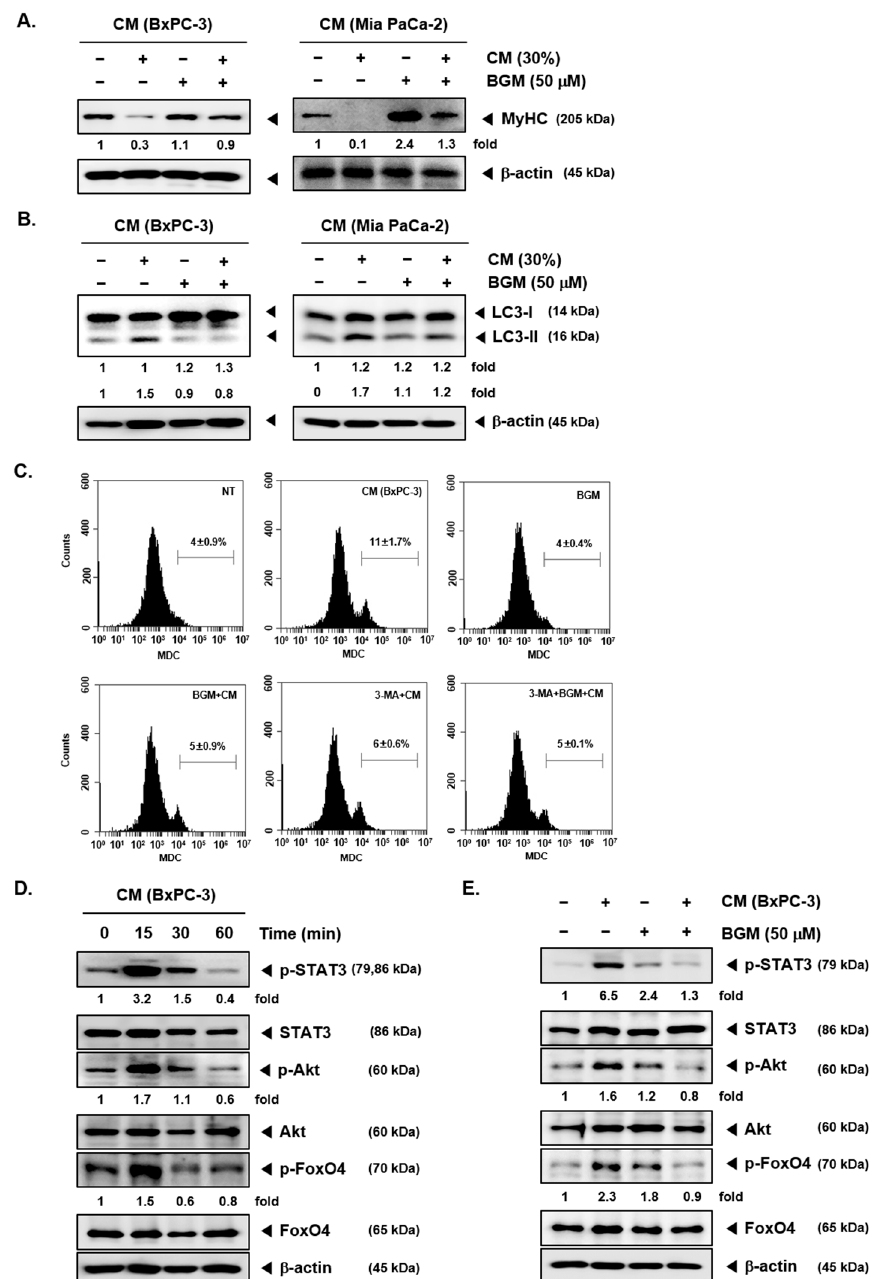
Figure 2. Effects of BGM on autophagy activation and various cancer markers suppression levels in C2C12 cells. C2C12 cells were treated by BGM (50 µM) with 30% of BxPc-3 and MIA PaCa-2 cells CM for 24 h. The lysates were analyzed by Western blot analysis and probed with